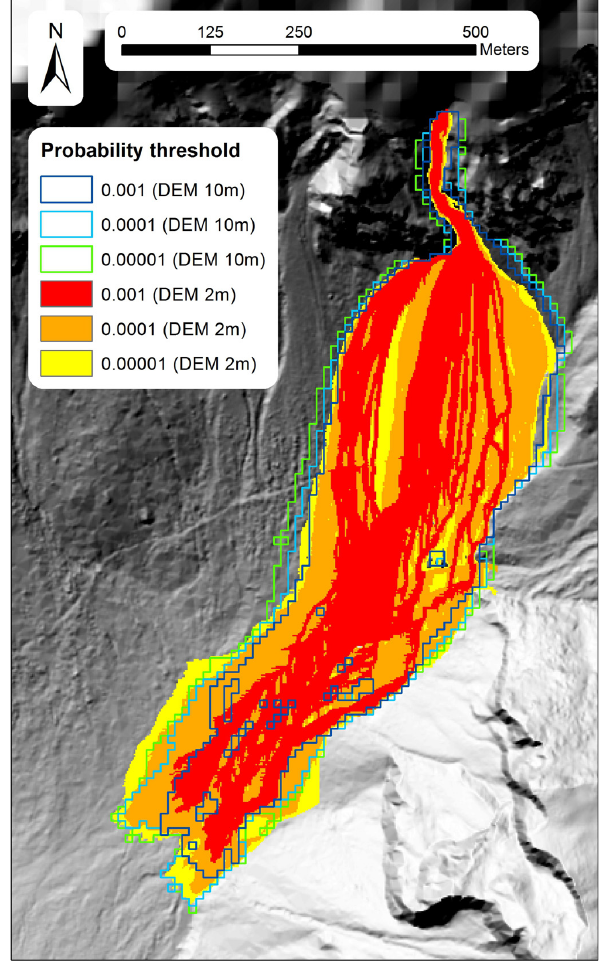
Fig. 11. Sensitivity of the spreading to the susceptibility threshold on a debris flow fan in Solalex, Switzerland (Geodata ©swisstopo –